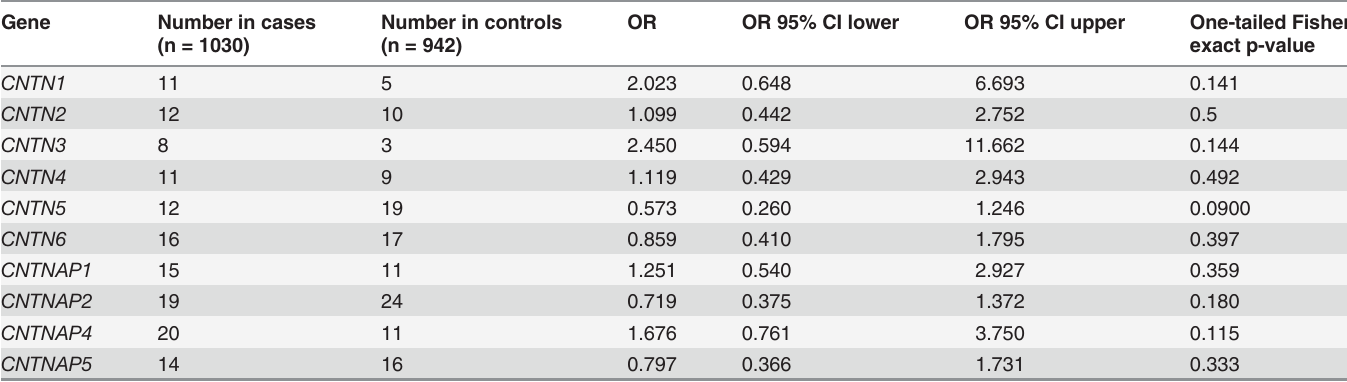
Table 2. Rates of singleton * mutations: all genes. Gene Number in cases (n = 1030)